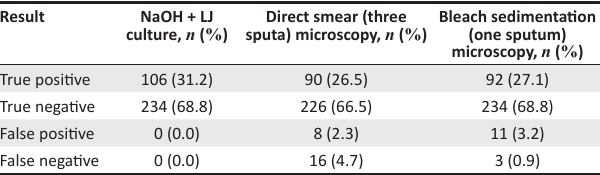
TABLE 3: Comparison of Ziehl-Neelsen microscopy for acid-fast bacilli using direct and bleach sedimentation-treated sputa with culture on Lowenstein- Jensen media following sodium hydroxide decontamination, Abuja, Nigeria, November 2004 to July 2005. Result